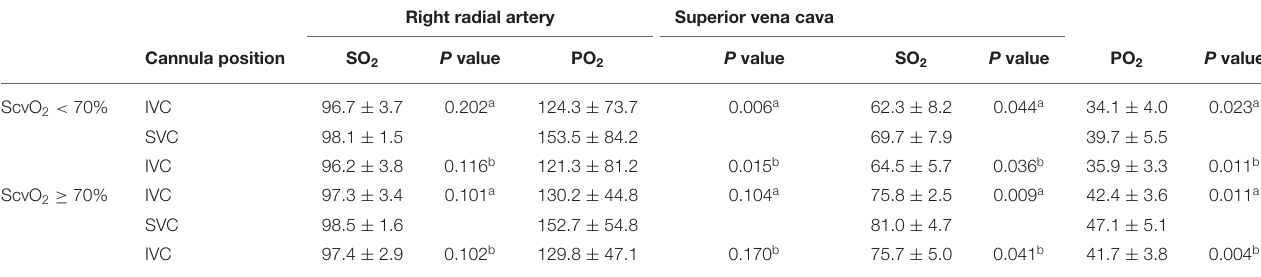
TABLE 3 | Blood gas analysis in upper body hypoxia group (ScvO2 < 70%) and upper body normoxia group (ScvO2 ≥ 70%). Right radial artery Superior vena